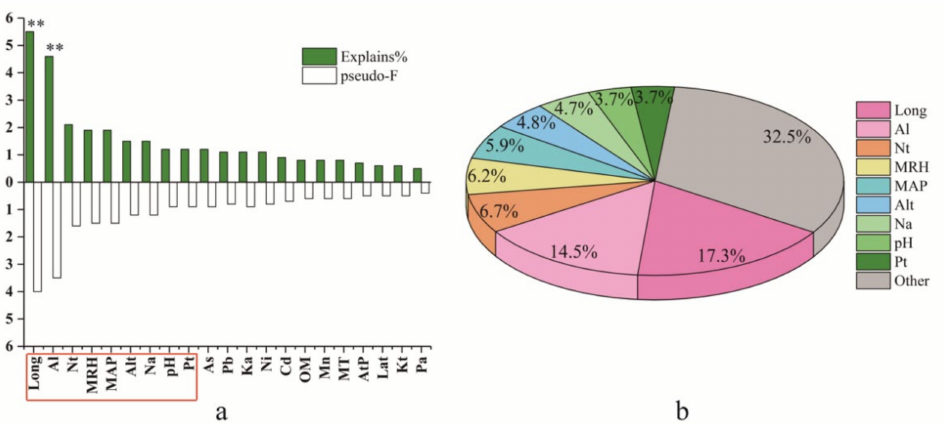
Figure 5. The effect of environmental factors on alkylamide variation for prickly ash pericarps: ( a ) the pseudo-F of each environmental factor and ( b ) key environmental factors. The symbol “**” represents the factor is significant; Long represents longitude; Al represents aluminum content in the soil; N t represents total nitrogen content in the soil; MRH represents the mean relative humidity; N a represents available nitrogen content in the soil; As represents arsenic content in the soil; pH represents power of hydrogen; MAP represents mean annual precipitation; Pb represents lead content in the soil; K a represents available potassium content in the soil; P t represents total phosphorus content in the soil; Ni represents nickel content in the soil; OM represents organic matter content in the soil; MT represents mean temperature; Alt represents altitude; Mn represents manganese content in the soil; Cd represents cadmium content in the soil; AtP represents atmospheric pressure; Lat represents latitude; K t represents total potassium content in the soil; and P a represents available phosphorus content in the soil.